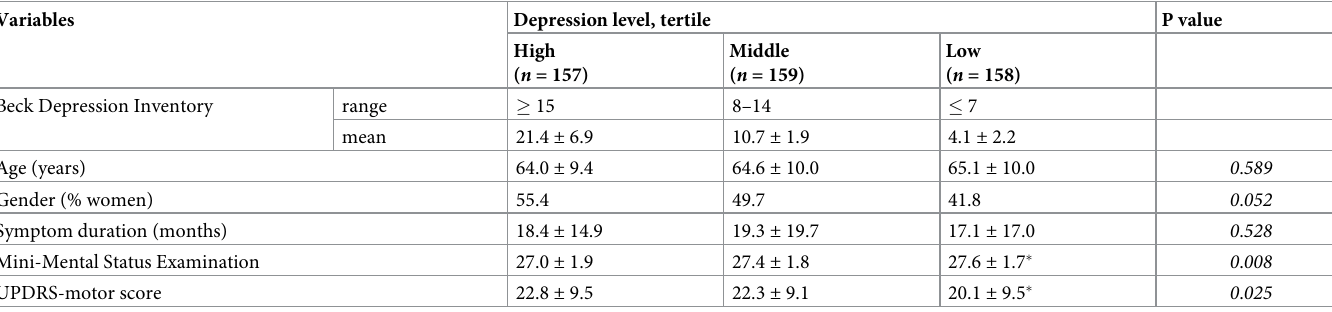
Table 1. Baseline clinical and demographic